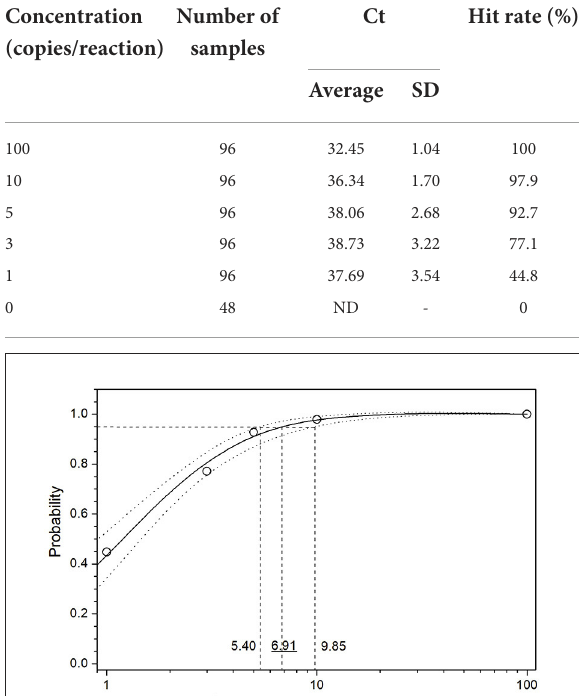
TABLE 3 Threshold cycle (Ct) values and hit rates of serially diluted samples.